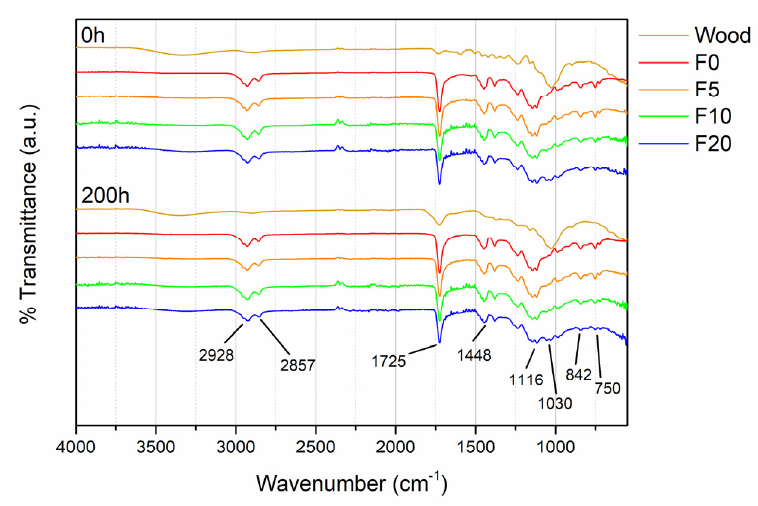
Figure 3. Evolution of the FTIR spectra of the samples before and after the exposure to UV-B radia- tion.